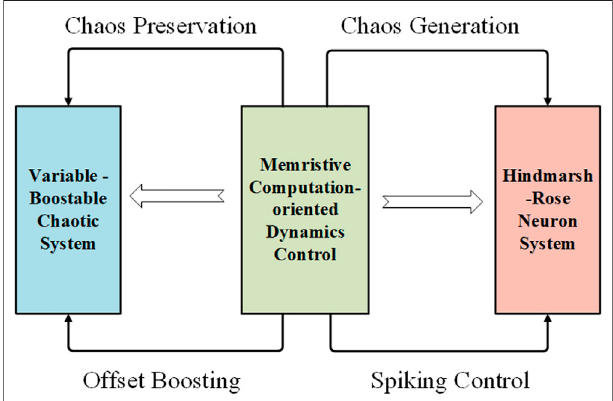
FIGURE 1 | Memristive computation-oriented dynamics.